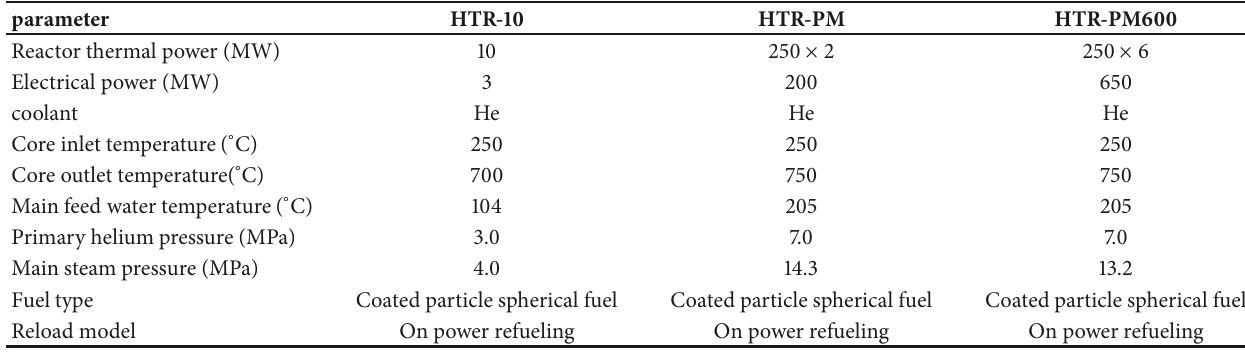
Table 1: main parameters of HTR-10, HTR-PM, and